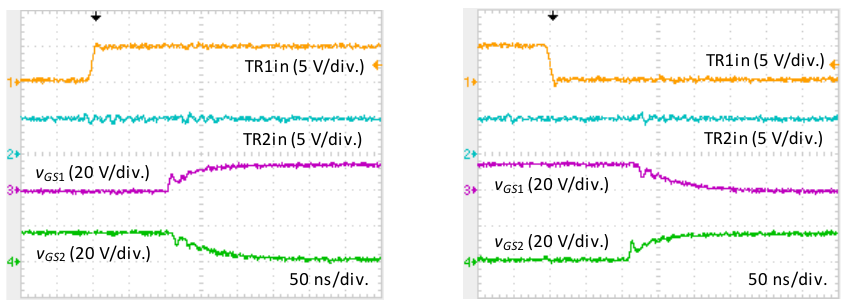
Figure 12. Waveforms showing behaviour at turn-on and turn-off of TR1. ( Left ) turn-on. ( Right ) turn-off. v a and v b were both measured with respect to HSG in Figure 9. The change in phase of v b with respect to v a is seen in each case. When TR1 is being signalled off, v b is still active as TR2 is being driven on.